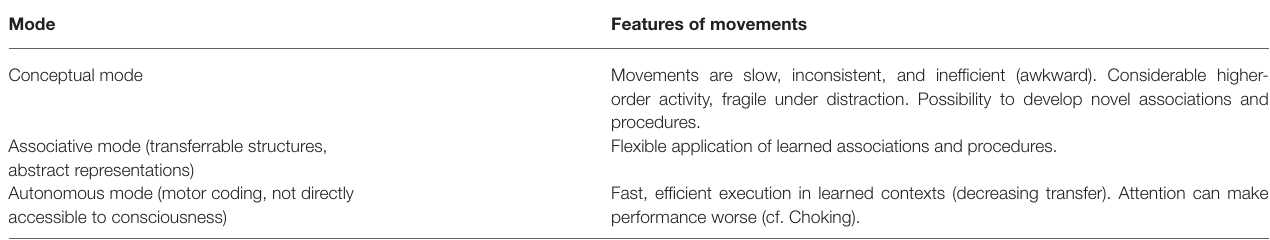
TABLE 2 | Modes of skill learning (adapted from Wulf, 2007)